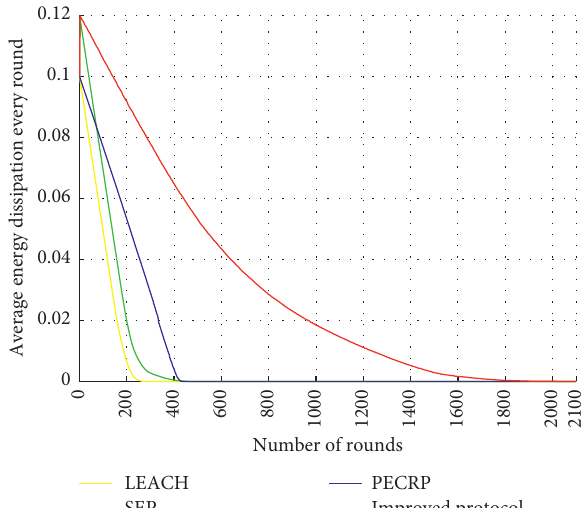
Figure 10: Comparison of average residual energy in each round without power supply. Table 3: Statistics of the average residual energy (J) of nodes of the four protocols without power supply.